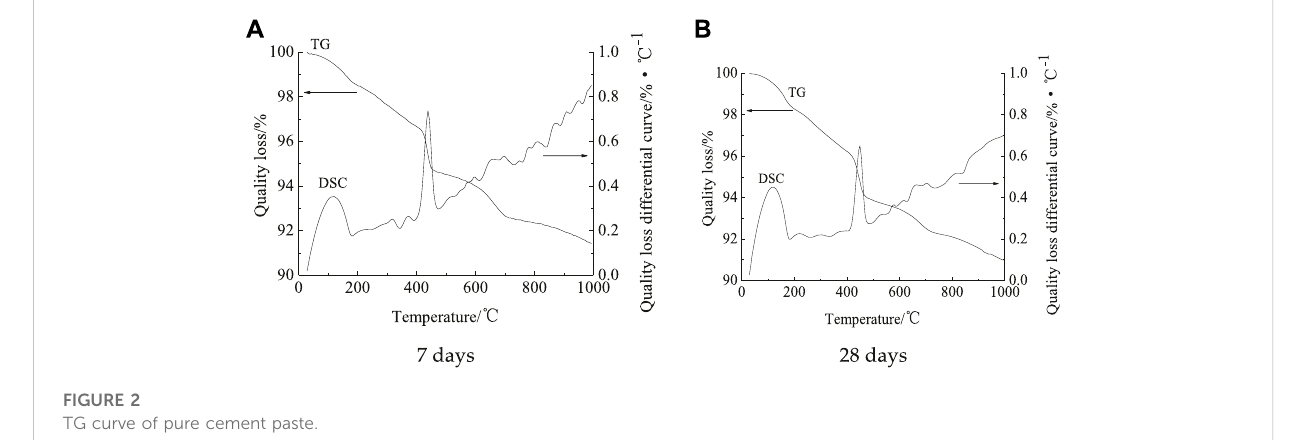
FIGURE 2 TG curve of pure cement paste.